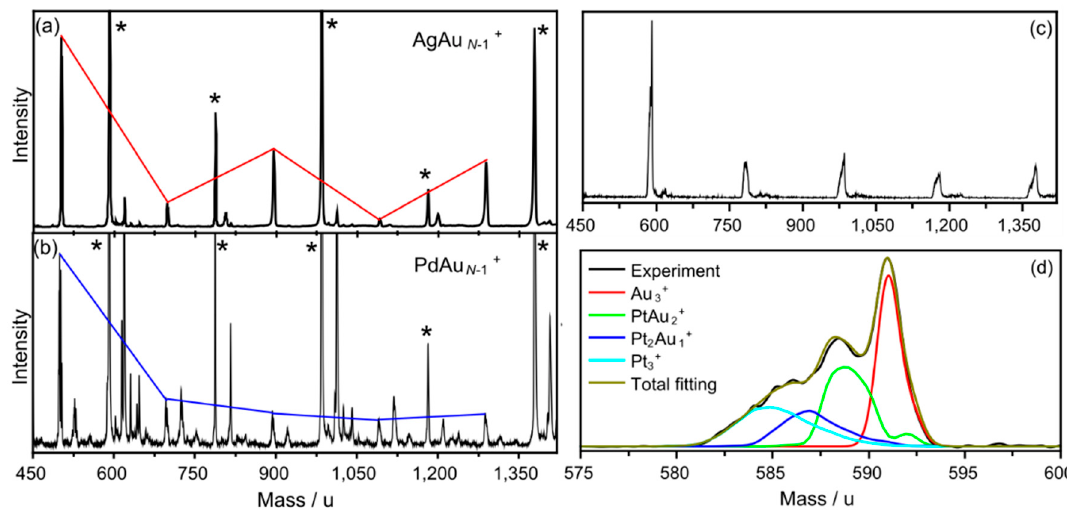
Figure 1. Parts of representative mass spectra of photofragmented clusters: ( a ) AgAu N − 1+ , ( b ) PdAu N − 1+ , and ( c ) PtAu N -1+ . In (a) and (b) continuous lines are included to aid visualization of the different abundances of the doped species. Pure Au N + clusters are marked by asterisks, whereas additional peaks correspond to carbon and oxygen contaminations or to doubly doped species of low intensity. ( d ) Deconvolution of the photofragmented cluster peaks around 580–595 u in panel ( c ): Au 3 + , PtAu 2 + , matching the natural isotopic distribution of each